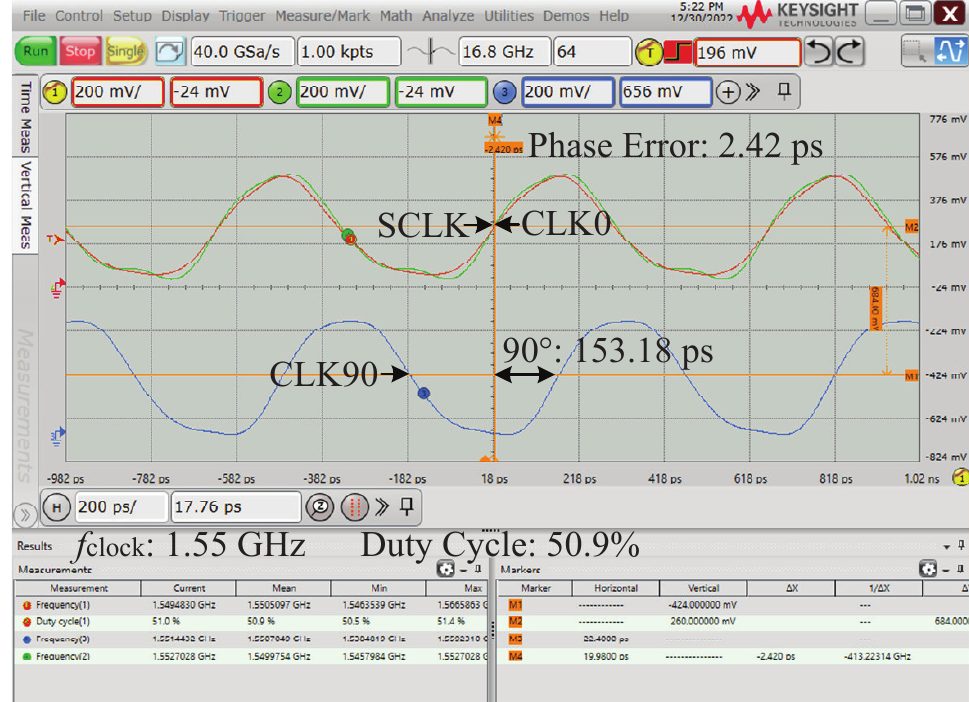
f clock : 1.55 GHz